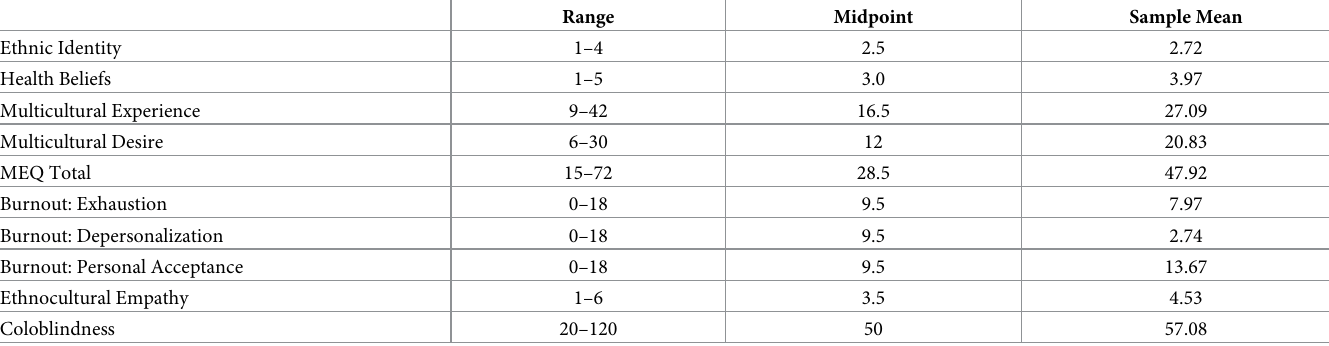
Table 2. Range and midpoint of variables of